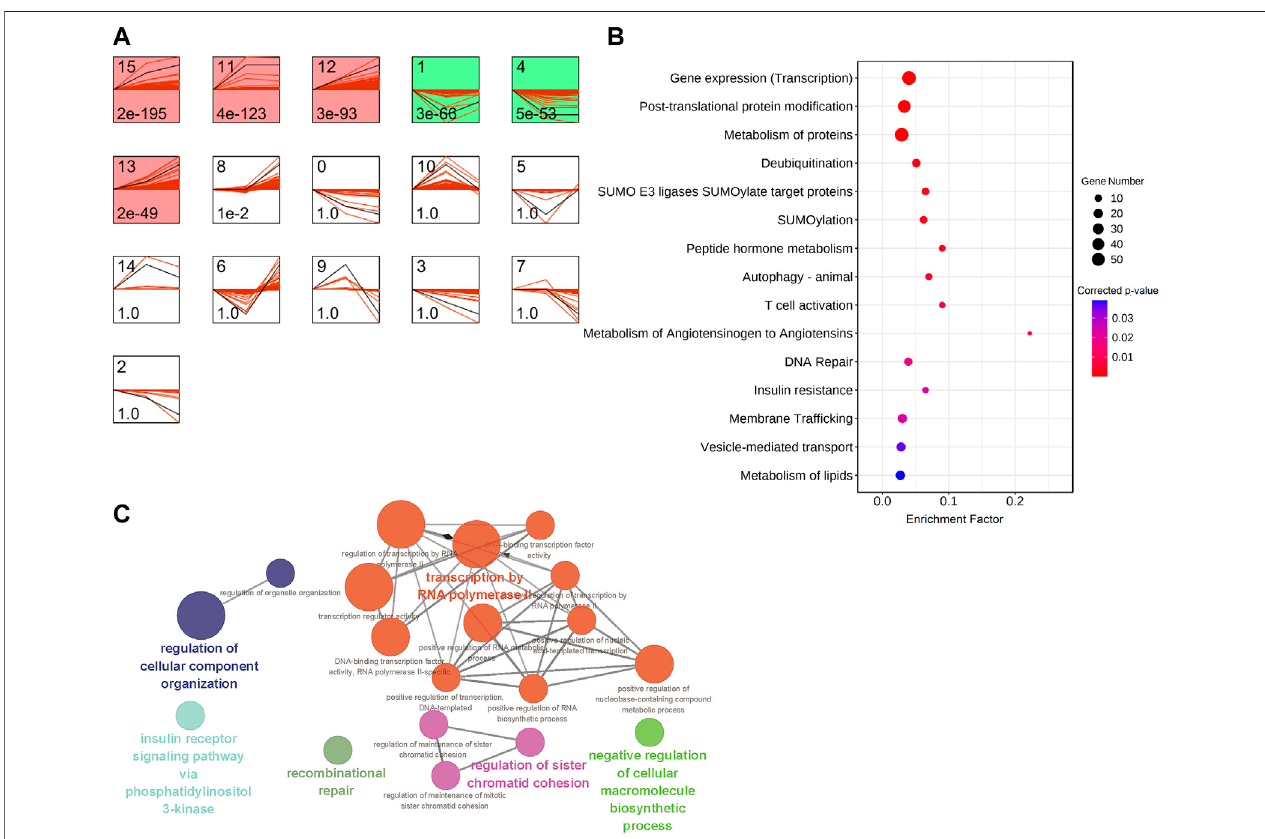
FIGURE 4 | Analysis of mRNAs expression temporal trends and functions in different phases of cervical dilatation. (A) STEM analysis of the mRNAs expression temporaltrends pattern. Thetopnumberindicates theserialnumberofpatternsand thebottom numberindicates p -value.Coloredpro fi lesindicate signi fi cantclustered ( p < 0.01) and the same color represents a similar expression pattern. Colored models meant a statistically signi fi cant number of genes were enriched. (B) Bubble diagram of partial signi fi cantly enriched pathways for mRNAs with more than two-fold change in expression in STEM pro fi le 1. (C) ClueGO plot of enriched BP GO annotation for mRNAs with more than two-fold change in expression in STEM pro fi le